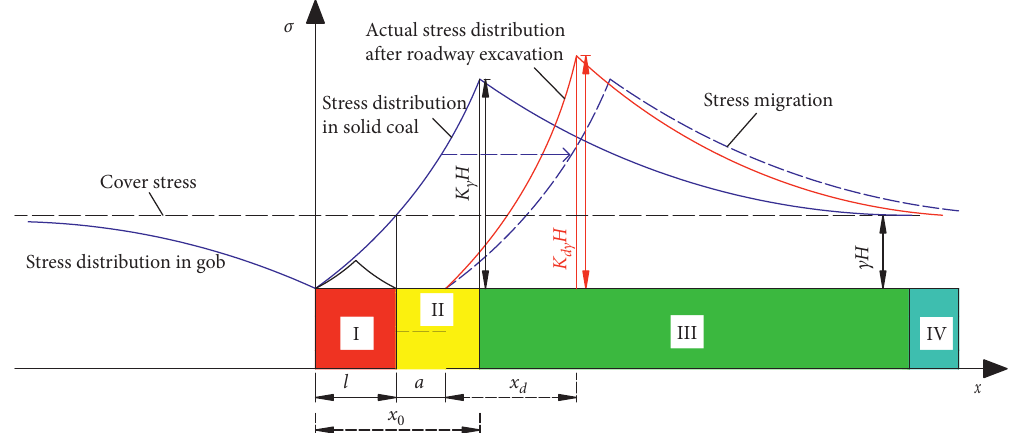
Figure 5: Distribution of abutment pressure of narrow coal pillar gob-side